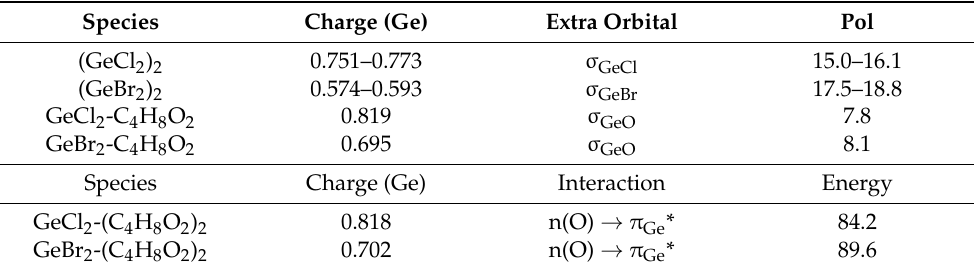
Table 5. The NBO BP86-D3/TZ2P results of calculations. The charge of Ge center is given and the extra bond orbital of the divalent Ge center changes into a trivalent one. In the latter case, the polarization (Pol) of the extra bond orbital is presented (percentage of the electron density at the Ge center). In complexes with two 1,4-dioxane molecules, the orbital-orbital overlap is given with the corresponding interaction of